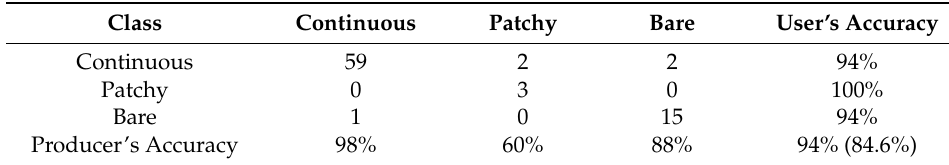
Table 4. Accuracy Matrix of the 3-class